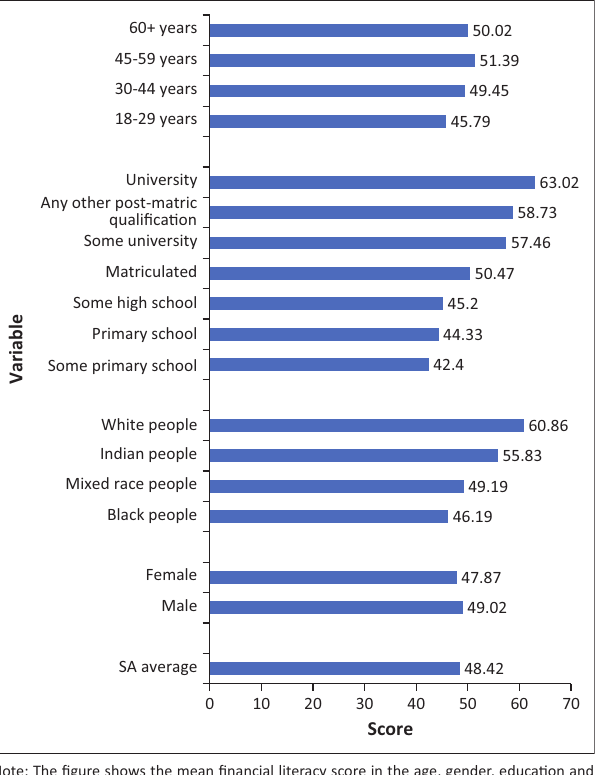
FIGURE 1: Financial literacy by age, education, gender and